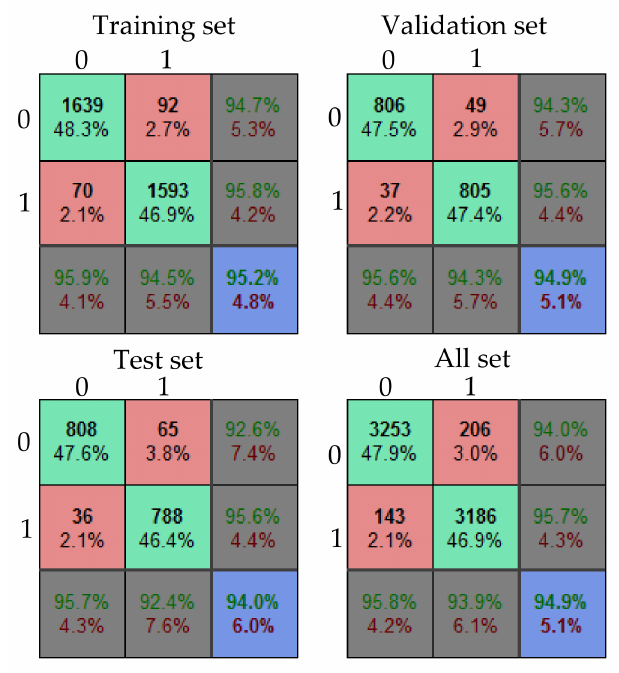
Figure 10. Training results using the BP neural-network model with 300 neurons in the hidden layer.